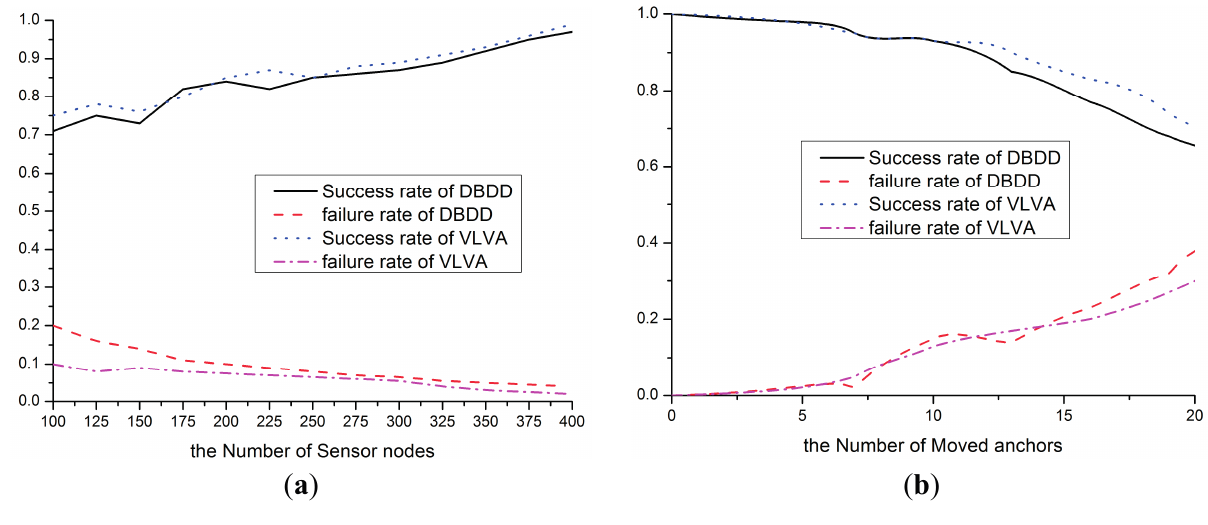
Figure 8. Location verification performance. ( a ) Performance vs number of anchor node; ( b ) Performance vs number of moved anchor node.